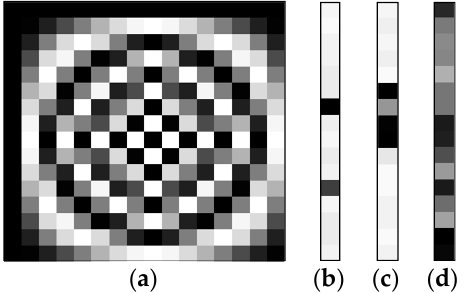
Figure 2. Diagram of Fourier basis and coefficient distribution of different interference types. ( a ) Fourier basis (real part); ( b ) radio frequency interference; ( c ) narrowband noise interference; and ( d ) wideband noise interference.